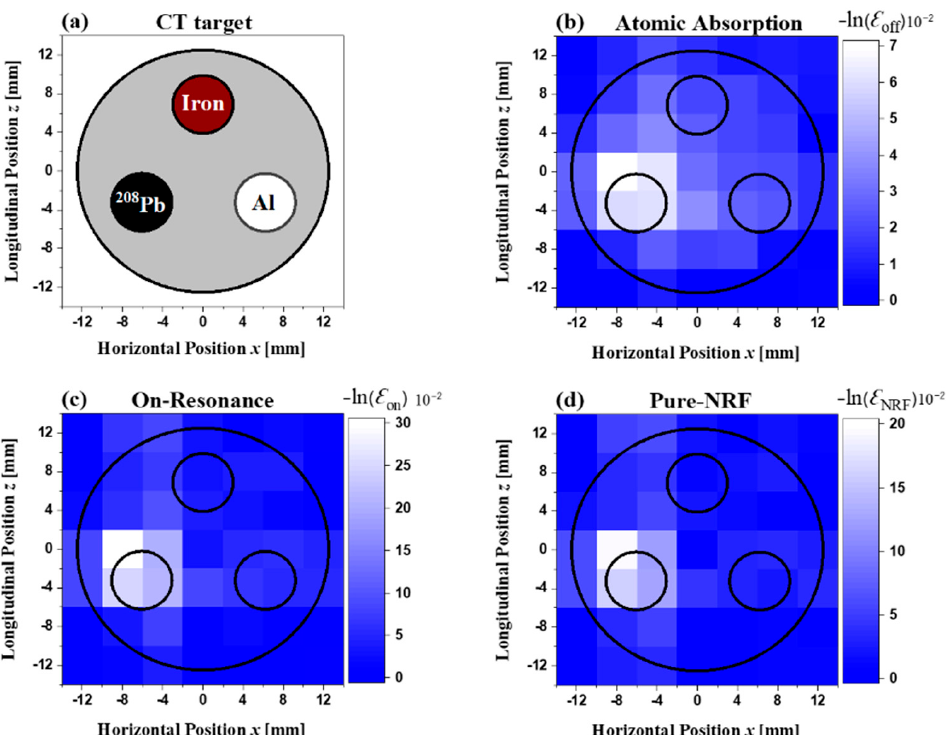
Figure 9. ( a ) CT target cross-sectional slice image at z = 11 mm, with reconstructed CT images of the ( b ) atomic attenuation, ( c ) on-resonance attenuation, and ( d ) pure NRF case.